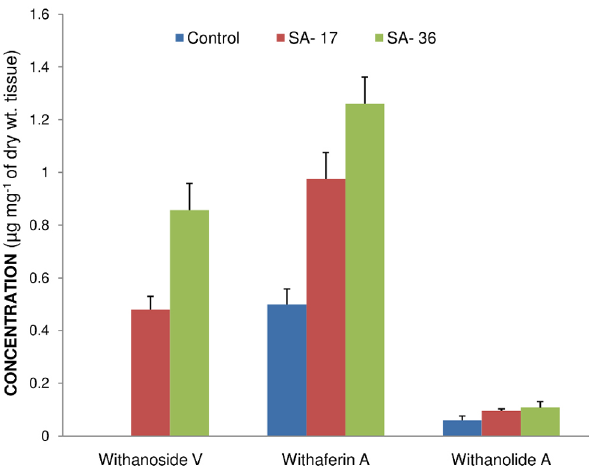
Figure 6. Quantitative variation in secondary metabolite content by exogenous application of salicylic acid. Control= Metabolite content in water treated leaf tissues; SA-17= Metabolite content in 17 hours post SA treated leaf tissues; SA-36= Metabolite content in 36 hours post SA treated leaf tissues. Presence of withano- side V was not detected in water treated (control) leaf